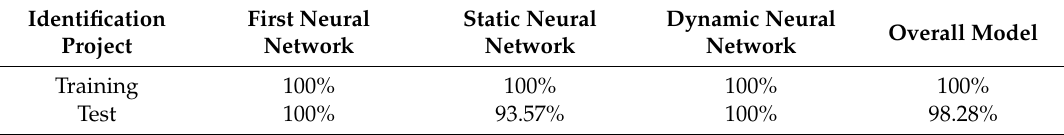
Table 4. Identification accuracy of each layer of neural